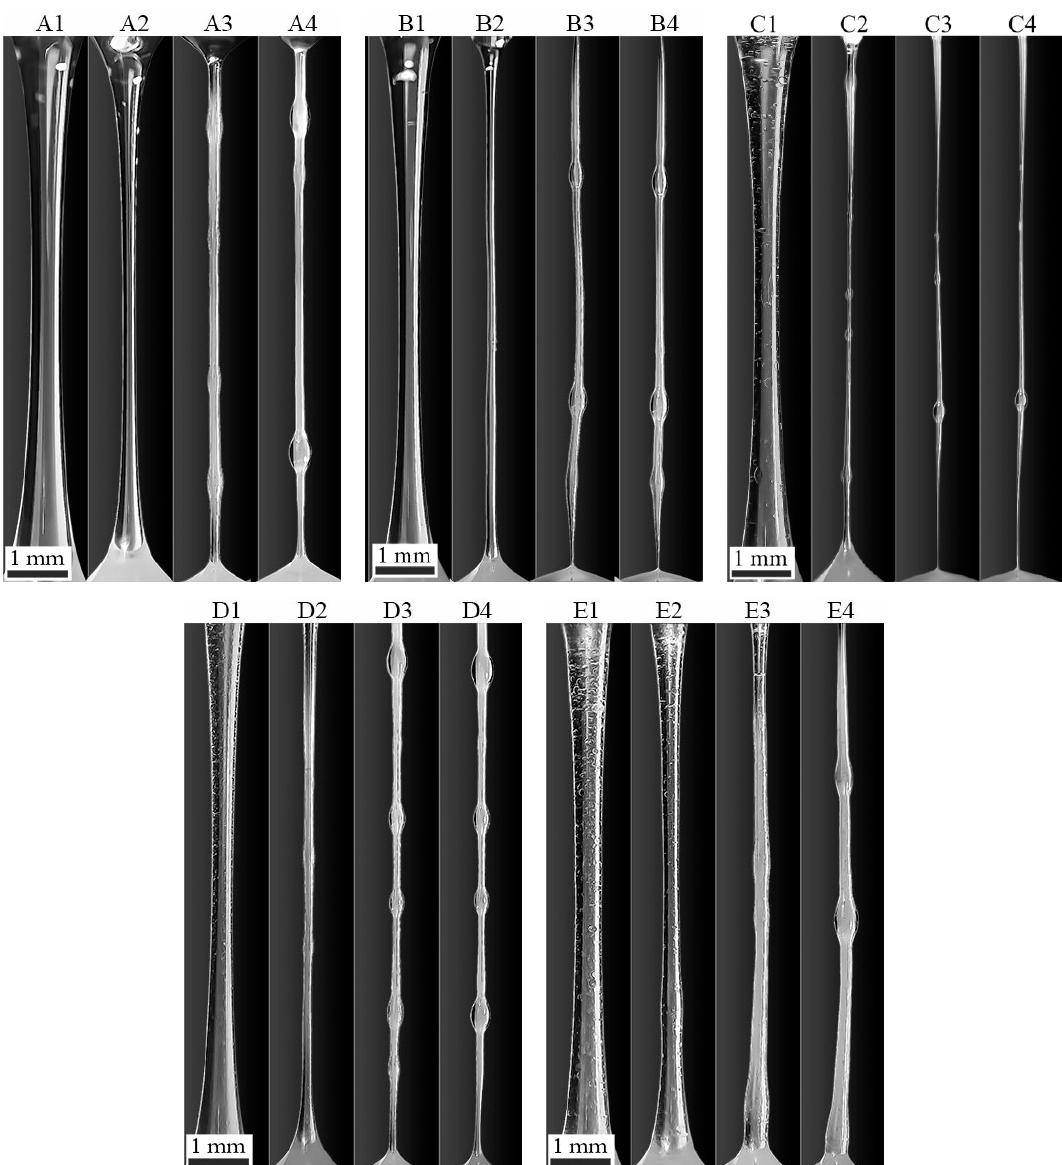
Figure 15. The evolution of the shape of the stretched jets based on 25% PAN solutions with polyorganosiloxane additives and the intensity of solvent release from jets. 1 — the initial moment of time, 2 — 10 seconds, 3 —30 seconds, 4 —80 seconds after stretching the drop to a constant length. Additives: A —the neat solution; B — 1% HMDSO; C — 5% HMDSO; D — 1% PDMS-100; and E — 5% PDMS-100.